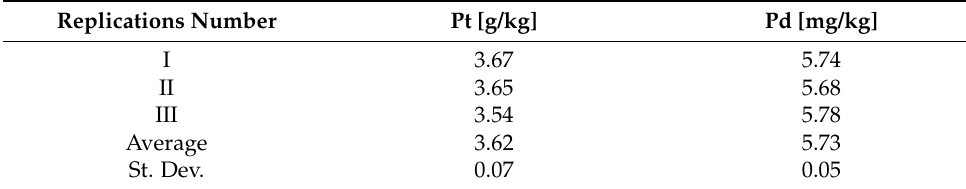
Table 1. Pt and Pd concentration within the SAC sample.